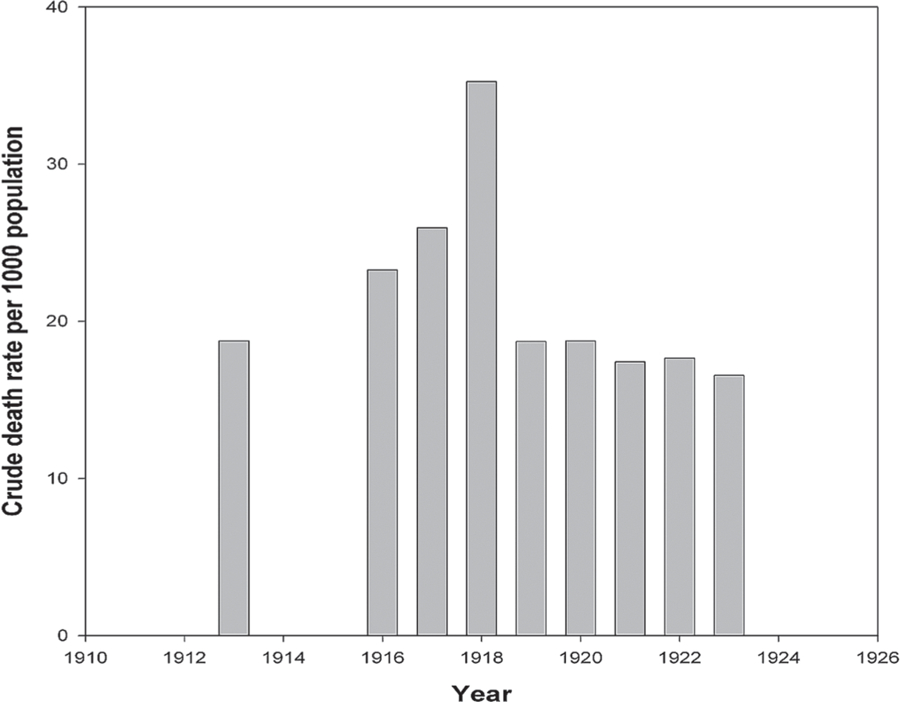
Crude death rate (per 1000 population), by calendar year in Italy. Source:
MAIC 1924, 1925a, 1925b